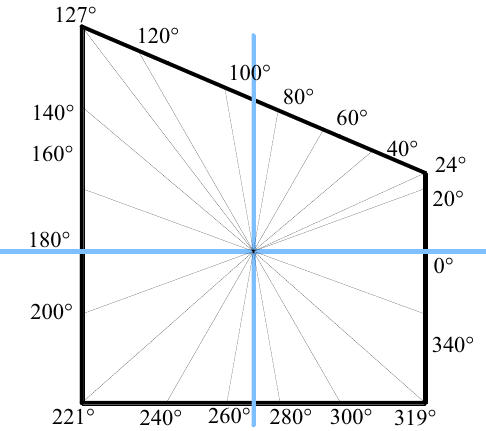
Figure 7. Roadway calculation azimuth